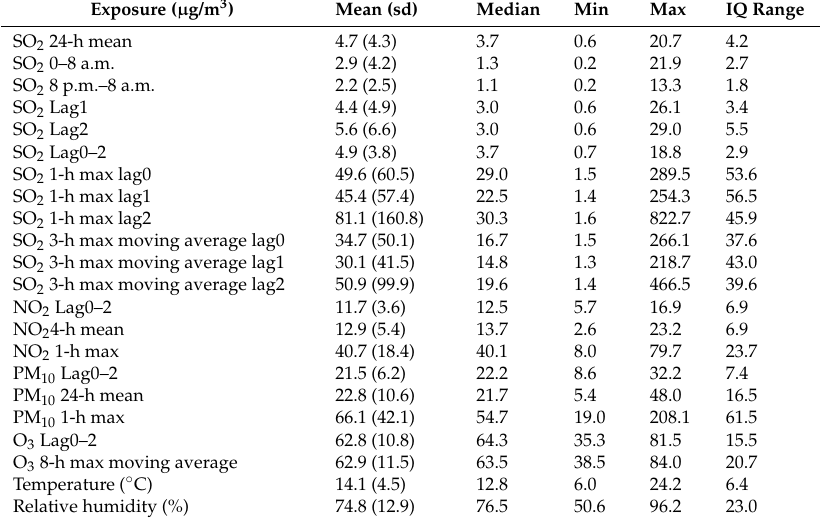
Table 3. Air pollutants concentration during Panel 20 study days. Sarroch (Sardinia), Italy (January–June